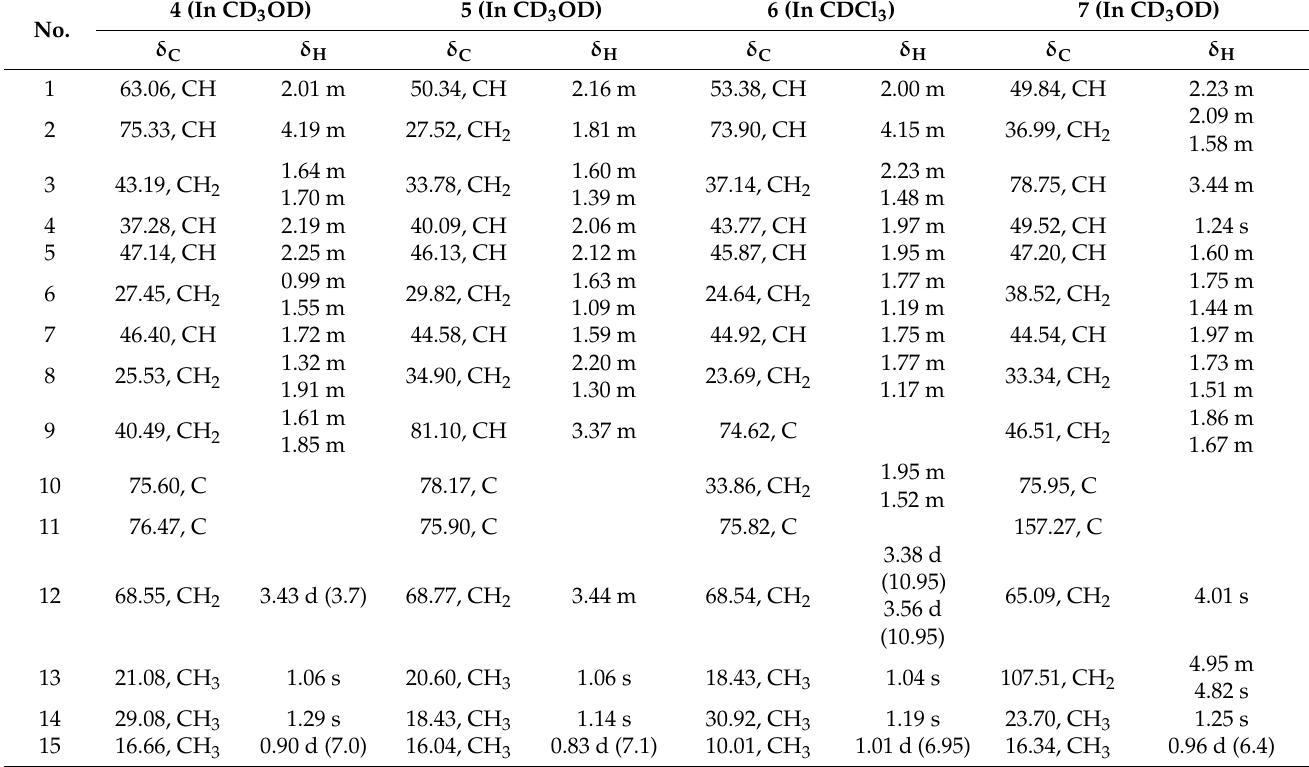
Table 2. 1 H (500 MHz) and 13 C (125 MHz) NMR data for compounds 4 − 7 ( δ in ppm, J in